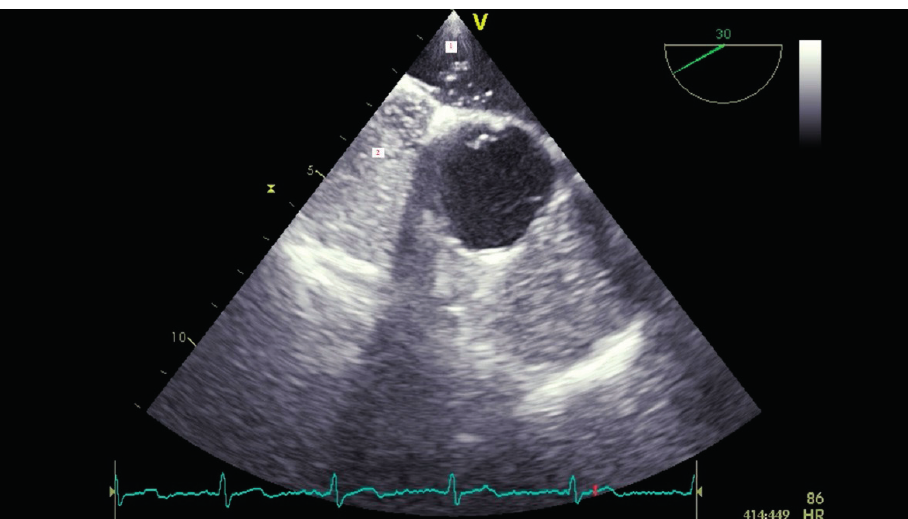
Fig. 3. Penetration of microbubbles of the contrast agent from the right to left atrium through PFO (bubbles in the left atrium indicated by No 1).